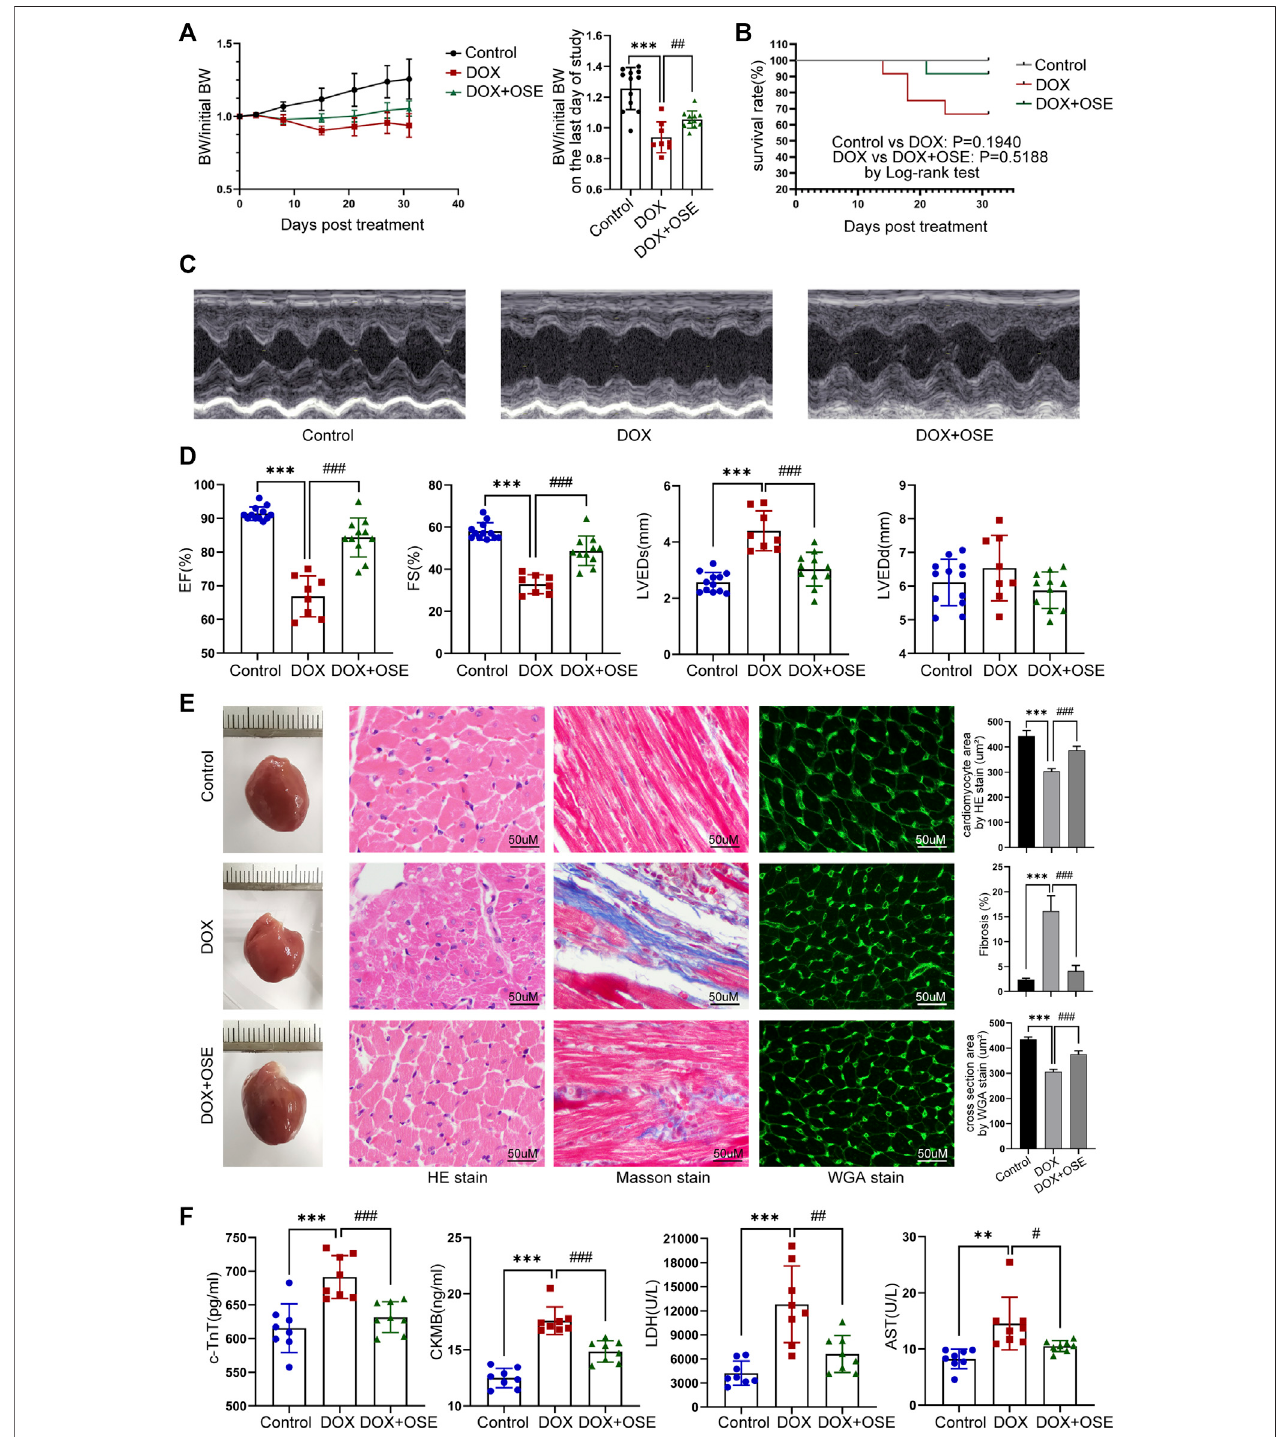
FIGURE 2 | NEU1 inhibitor improved DOX-induced cardiac dysfunction in rats. (A) The tendency of body weight change of rats in three groups ( n (cid:1) 12 per group). (B) The survival curve of rats in different groups. (C) Representative images of M-mode echocardiography in different rat groups at the endpoint of the study. (D) Statistical analyses of echocardiographic parameters including ejection fraction (EF), fractional shortening (FS), left ventricular end-systolic dimension (LVEDs), and left ventricular end-diastolic dimension (LVEDD) of rats in the three groups at the end of the study. (E) Representative images of hematoxylin and eosin (HE) staining, Masson ’ s trichrome staining, and wheat germ agglutinin (WGA) staining of heart tissues in the three different groups, which display the extent of cardiac atrophy, myocardial fi brosis, and cell sizes, respectively (scale bar (cid:1) 50 μ m). (F) Concentrations of cardiac injury markers including cardiac troponin T (cTnT), creatine kinase isoenzyme-MB (CK-MB), lactate dehydrogenase (LDH), and aspartate aminotransferase (AST) in plasma of rats in different groups. (** p < 0.01 vs. control group, *** p < 0.001 vs. control group. # p < 0.05 vs. DOX group, ## p < 0.01 vs. DOX group, ### p < 0.001 vs. DOX group).